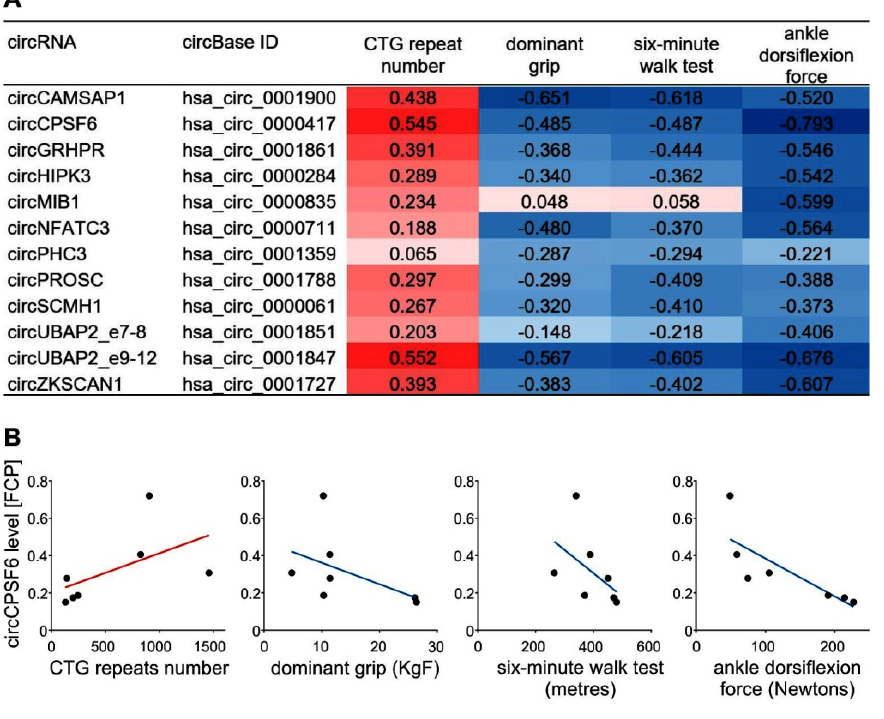
Figure 3. The correlation between global circRNAs levels and DM1 severity. ( A ) Listed are exemplary circRNAs which expression levels were found increased in skeletal muscles from DM1 patients [40]. Biomarkers of DM1 muscle severity, i.e., CTG repeat number, dominant grip, six-minute walk test and ankle dorsiflexion force are shown and the intensity of red and blue colors indicates, respectively, the level of positive and negative correlation. ( B ) Plots depicting the correlations of CTG repeat number, dominant grip, six-minute walk test and ankle dorsiflexion force are shown for exemplary circCPSF6 which global expression level (expressed as a fraction of circular particles, FCP) was found elevated in DM1 human muscle (for details please see Czubak et al. [40]).